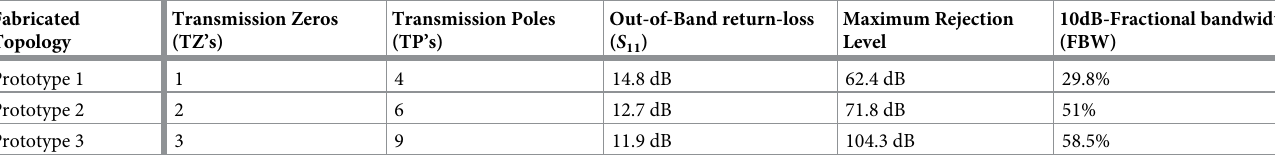
Table 1. Comparison between proposed three